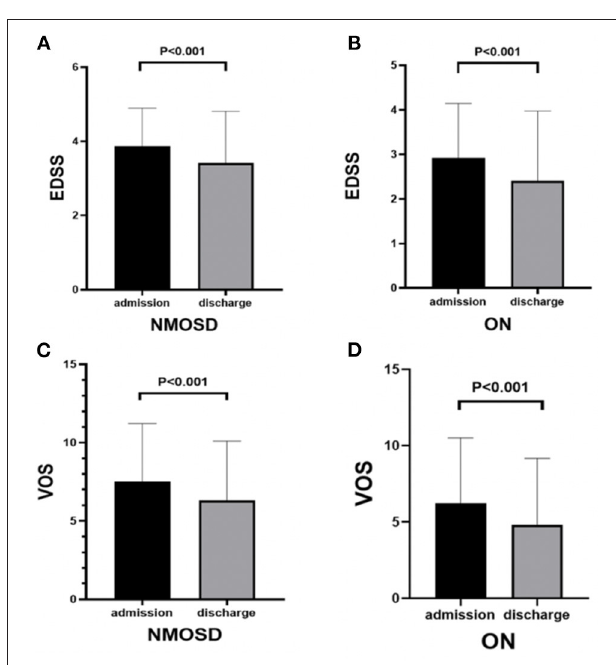
FIGURE 2 | Comparison of EDSS and VOS scores before and after methylprednisolone treatment in NMOSD and ON groups: (A) EDSS scores of NMOSD at admission and discharge. (B) EDSS scores of ON at admission and discharge. (C) VOS scores of NMOSD at admission and discharge. (D) VOS scores of ON at admission and